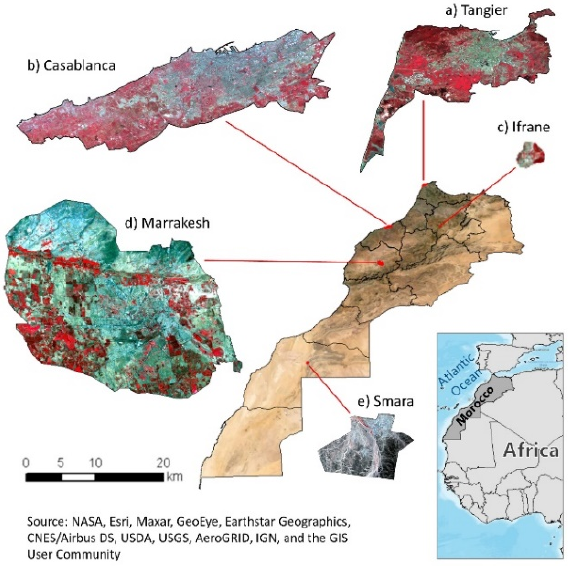
Table 1. Landsat 8, cloud free, surface temperature product scenes-dates averaged for summer 2016. The local observation time for all scenes was ~12:00 p.m.